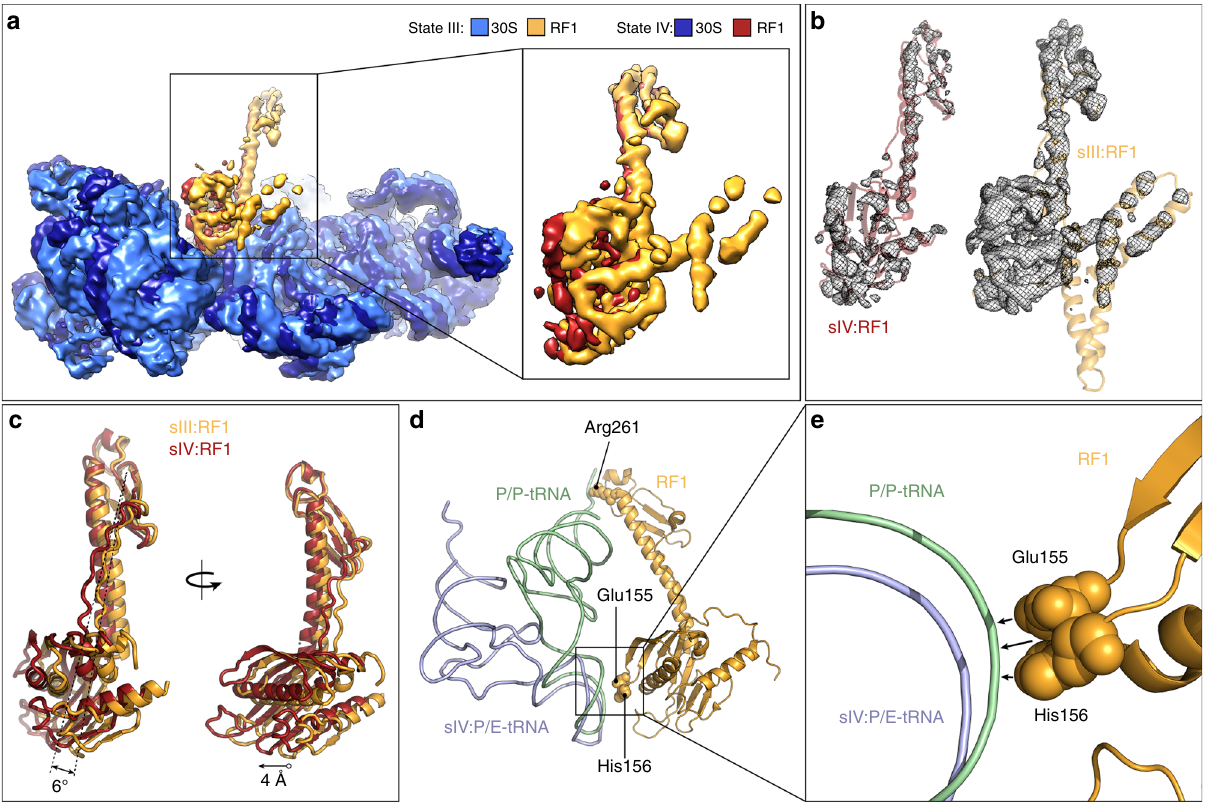
Fig. 6 RF3-induced subunit rotation destabilizes RF1 binding. a Cryo-EM map of SSU (light blue) and RF1 (orange) from state III compared with SSU (dark blue) and RF1 (red) from state IV. b Isolated cryo-EM electron densities (grey mesh) with molecular models for RF1 from state III (orange) and state IV (red) shown at the same contour level based on comparison with the SSU density. c Domain 2/4 of RF1 from state III (sIII:RF1, orange) is rotated by 6° and shifted by 4 Å compared to RF1 from state IV (sIV:RF1, red). d , e Contacts (arrowed) between RF1 (orange) and P/P-tRNA (green) are lost upon formation of the hybrid P/E-tRNA (light blue). Amino acids of RF1 that contact P/P-tRNA are shown as spheres. e Zoom of d showing the presence or absence of RF1 contacts with the ASL of P/P- or P/E-tRNA, respectively